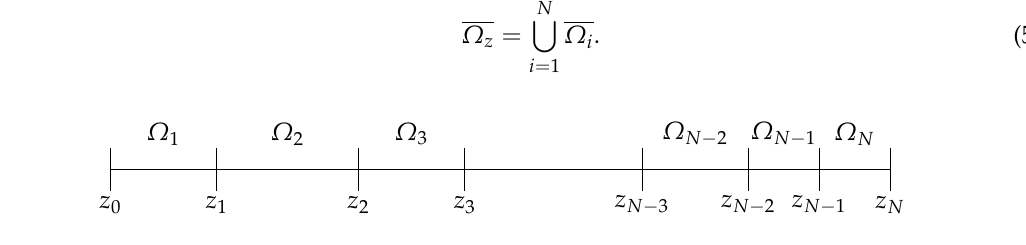
Figure 2. Selected decomposition points z 1 , · · · , z N − 1 in the domain ( z 0 , z N ) . Ω 1 , Ω 2 , · · · , Ω N are the sub-domains associated to the decomposition points.